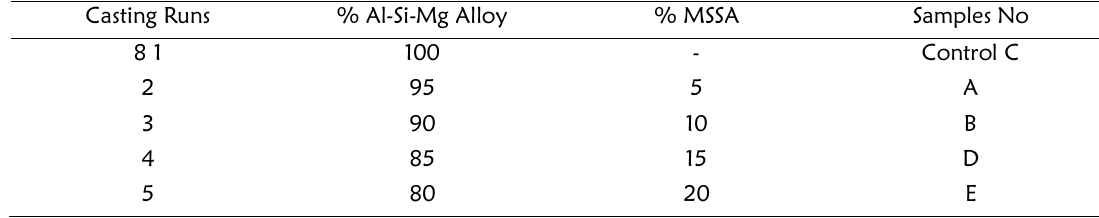
Figure.2: Casting procedures. Table 1: charging of matrix and reinforcement into crucible